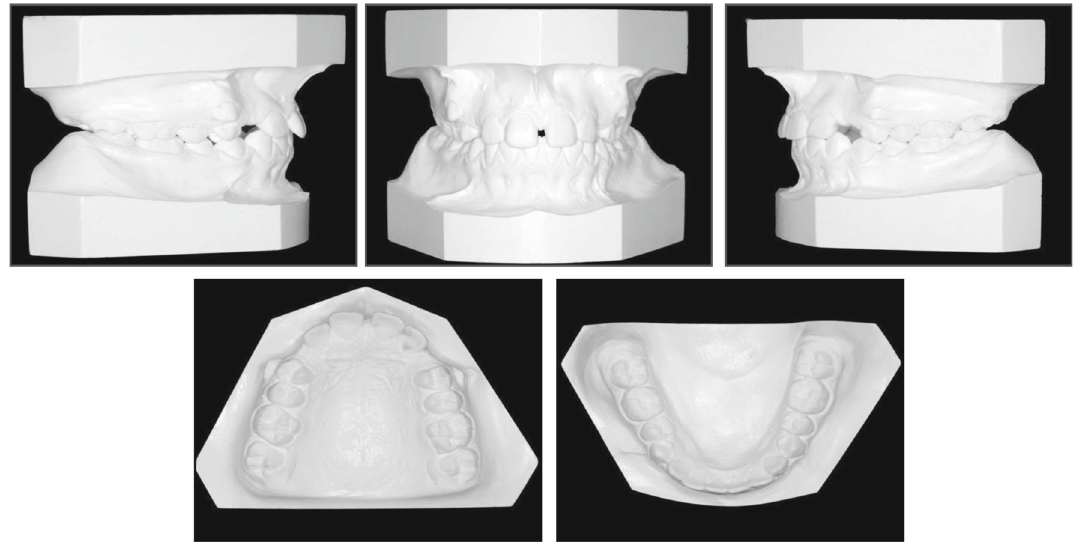
Figure 2: Pretreatment dental casts.